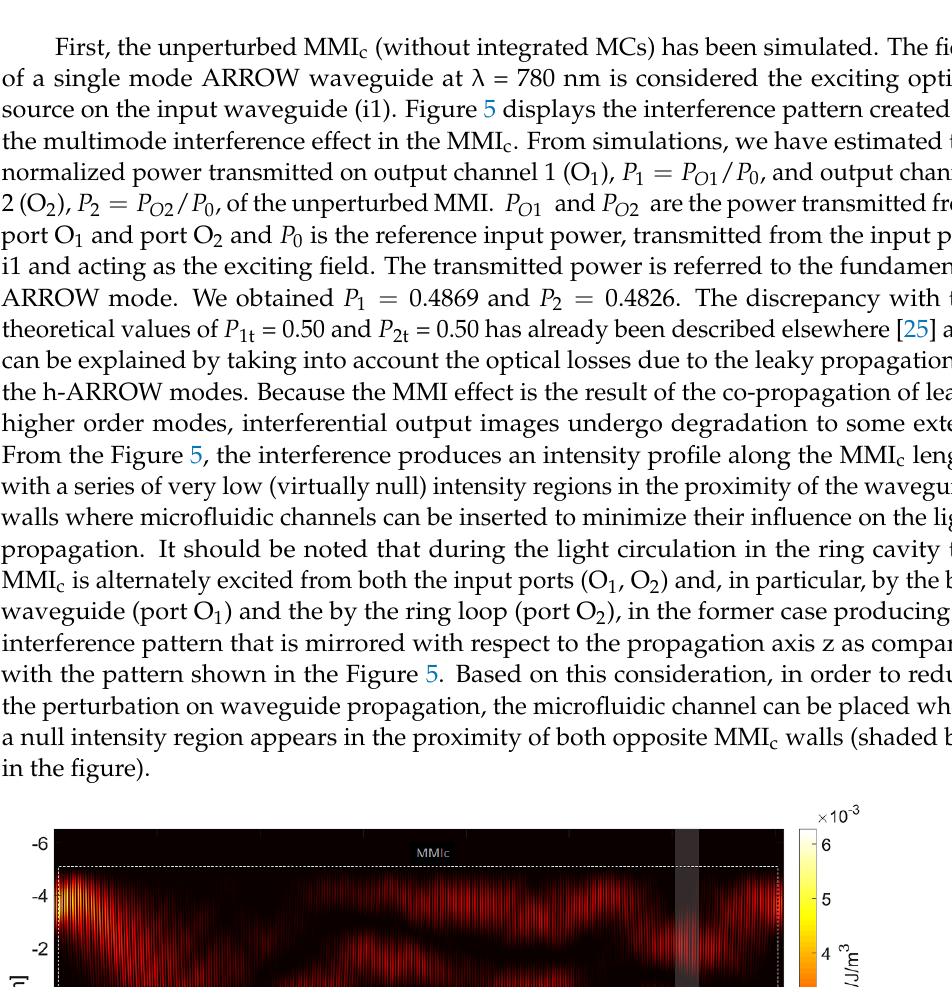
respectively. The results are summarized in Table tively. The results are summarized in Table 1. Table 1. Transmitted power from the MMI c in all the explored cases.